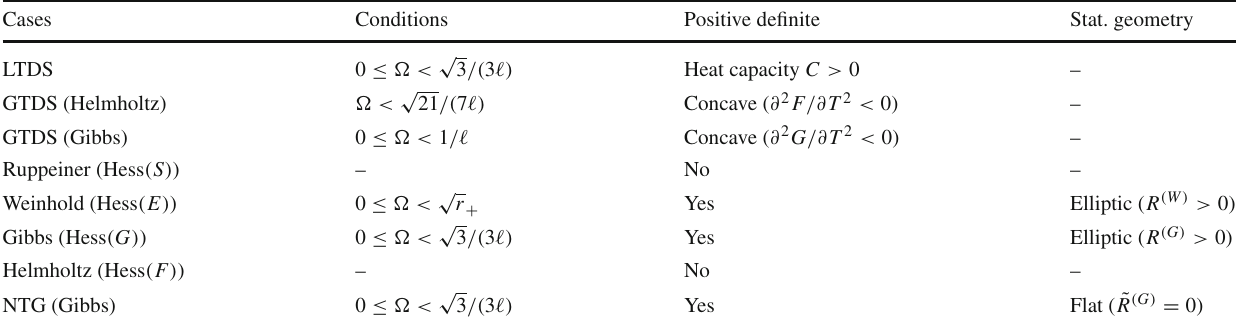
Table 1 Conditions for thermodynamic stability in different cases. Notations in the table are as follow: LTDS (local thermodynamic sta- bility), GTDS (global thermodynamic stability), NTG (new